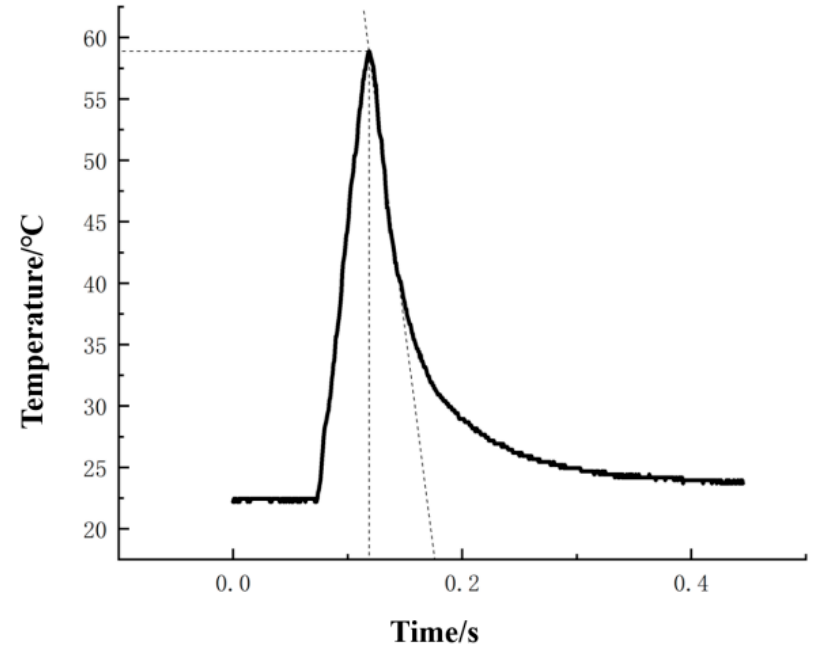
Figure 11. Milling transient temperature profile.